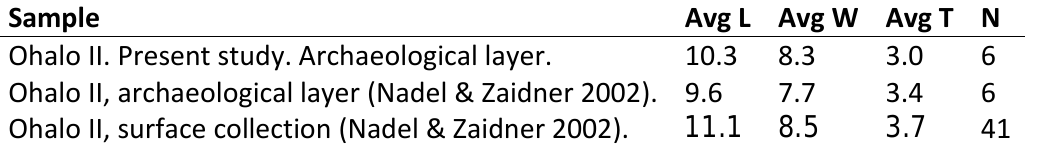
Table 4. Average dimensions (cm) of double notched weights from Ohalo II. Abbreviations: Avg L - average length; Avg W - average width; Avg T - average thickness; N - number of samples.